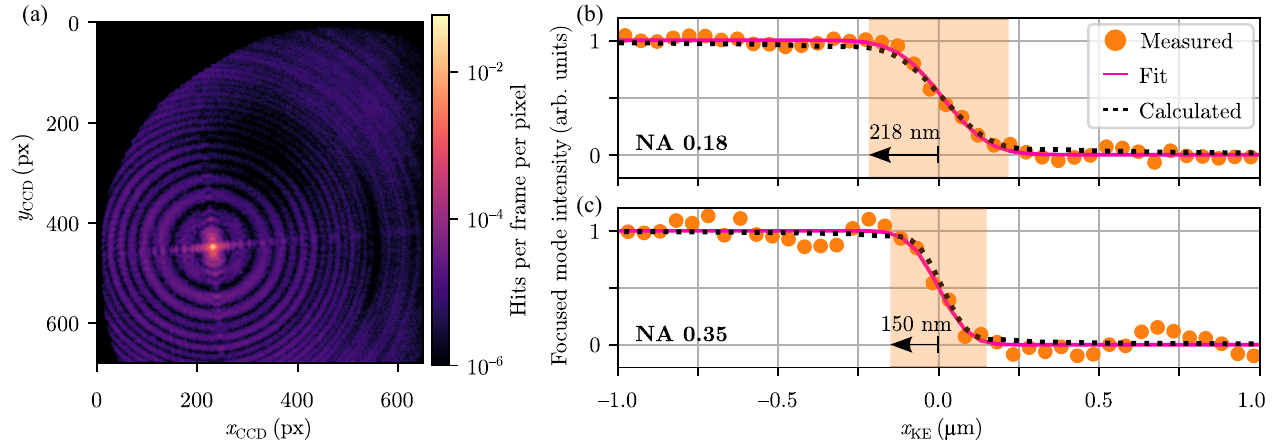
FIG. 2. (a) Diffraction of XUV light from the 0.35-NA Fresnel zone plate imaged by the phosphor screen. One pixel corresponds to about 40 - μ m size. (b),(c) Scan of the knife edge across the XUV focus for the 0.18-NA (b) and 0.35-NA (c) zone plates. Slowly varying contribution of the unfocused mode is subtracted. The solid purple line is a fit of a cumulative Gaussian distribution function to the data, with waist radius ( 1 =e 2 ) as the only fit parameter. The dashed black line is the theoretical expectation obtained by simulating the knife- edge scan across a two-dimensional beam profile at the zone plate ’ s focal plate. The focused beam profile is calculated by propagating the expected XUV distribution on the MgO surface to the focus with the angular spread method.